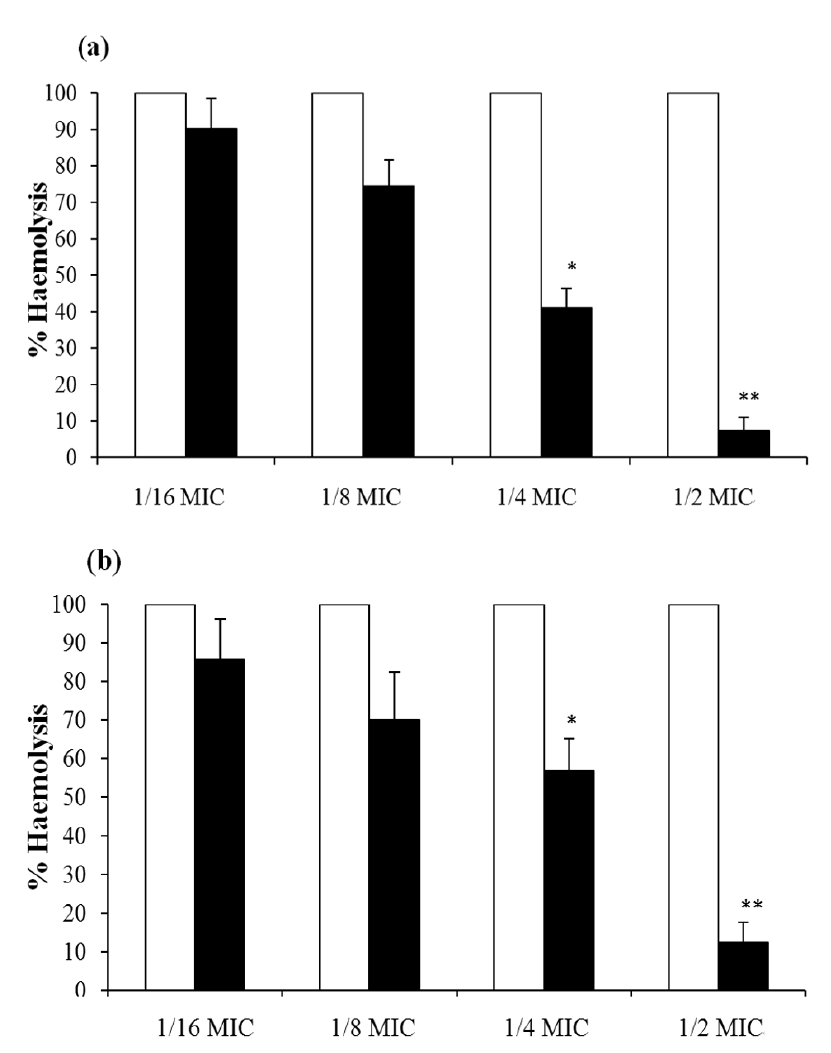
Figure 3. Haemolysis of rabbit erythrocytes by supernatants of cultures of MSSA strain ATCC 29213 (a) and MRSA strain 3701 (b) in the absence ( □ ) or presence ( ■ ) of different concentrations of magnolol. Values represent the mean of three independent experiments, and the error bars show standard deviations. * represents p < 0.05, and ** represents p <